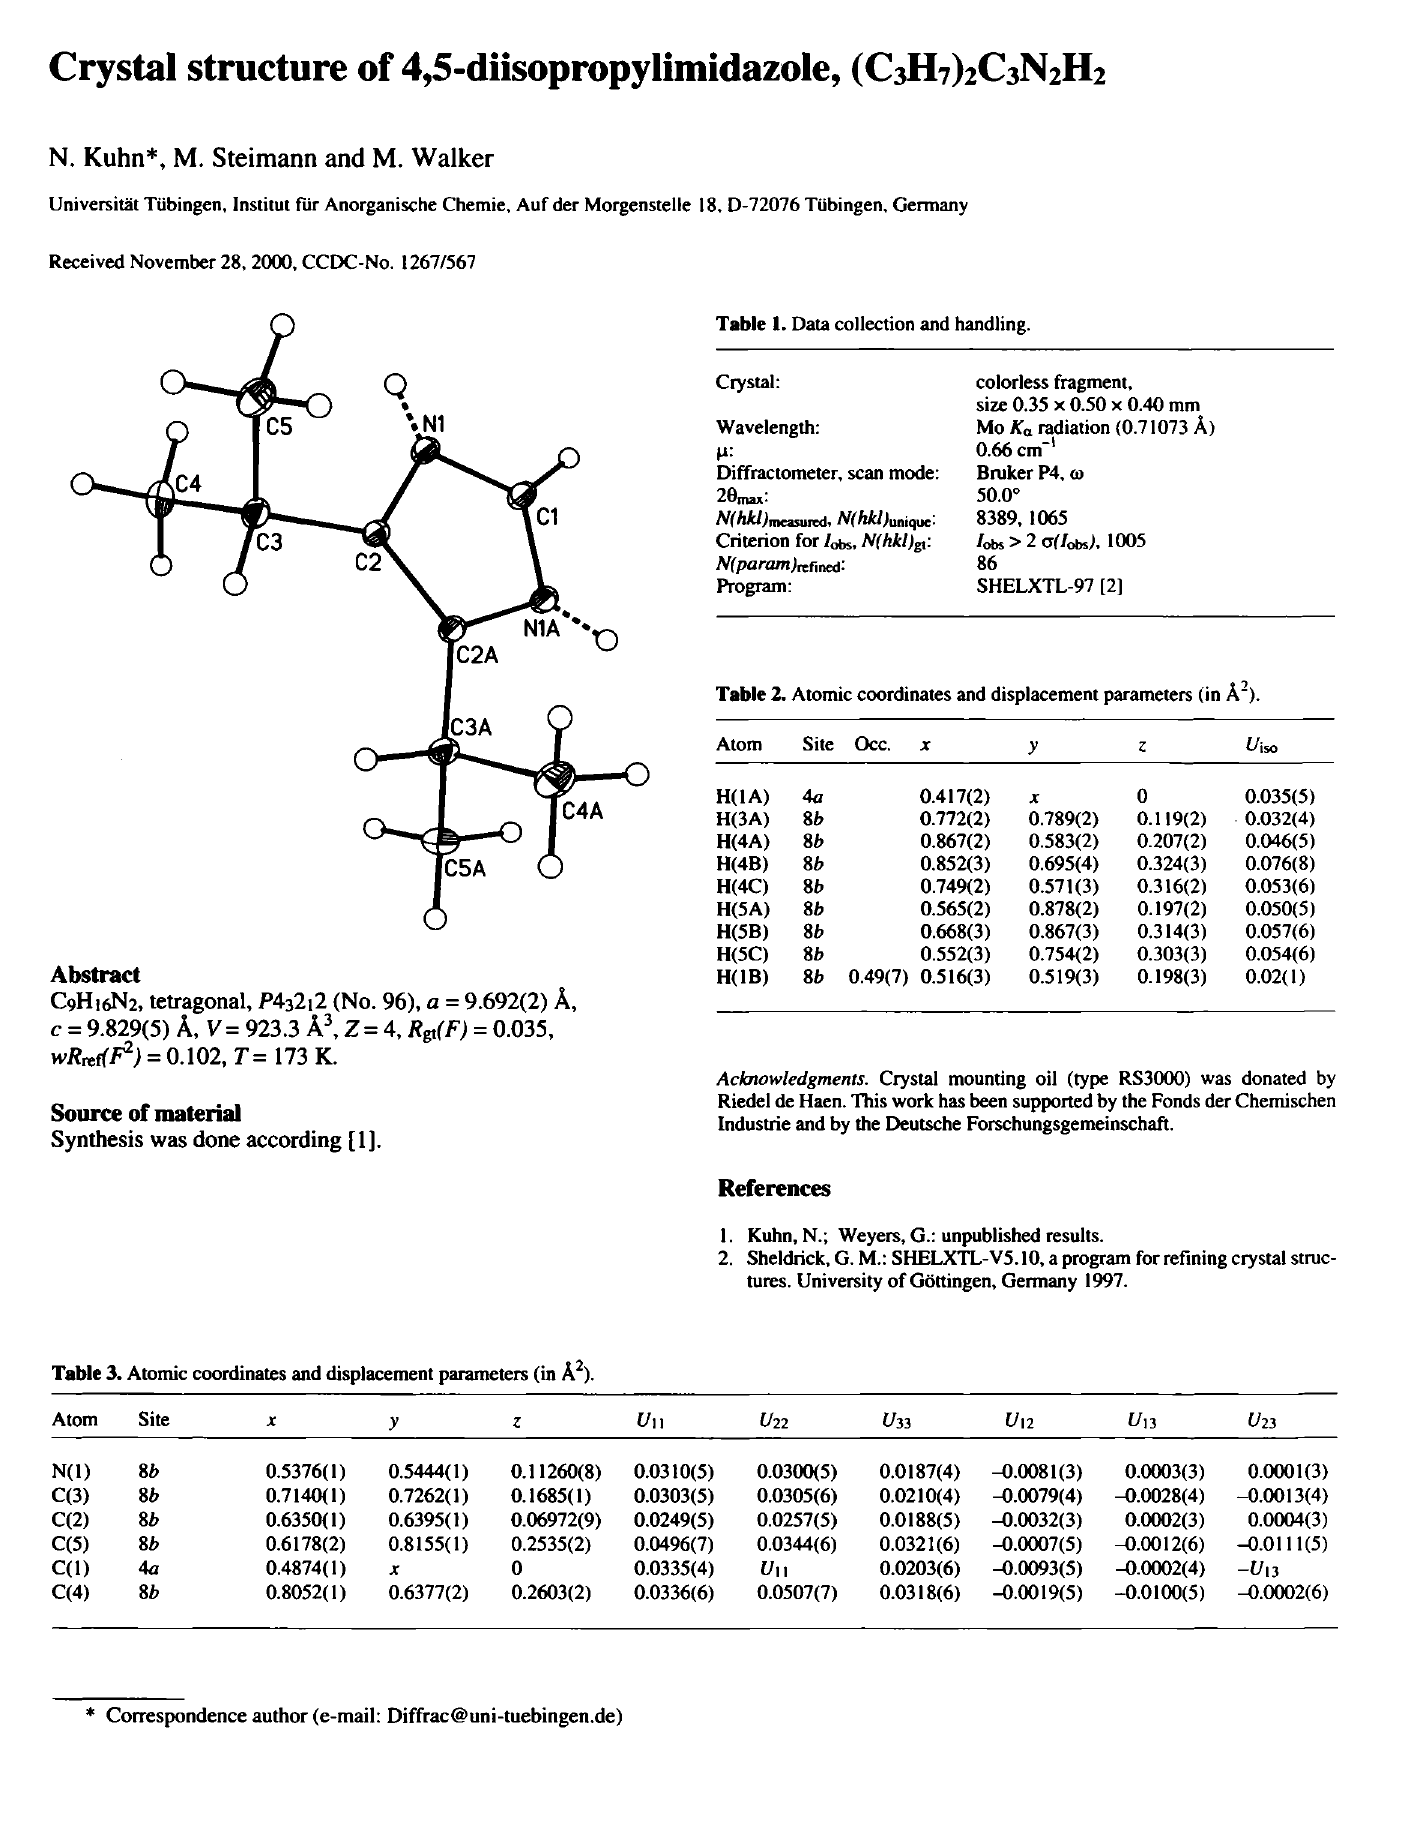
Table 1. Data collection and handling.